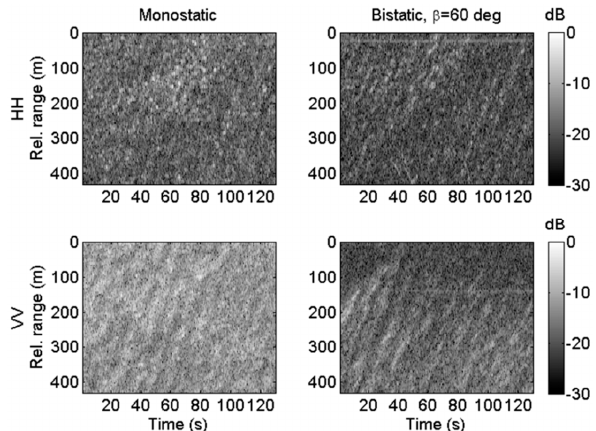
Figure 4. NetRAD: S-band time domain intensity images, monostatic (left), and bistatic 60° (right) for HH (top) and VV (bottom) polarizations.